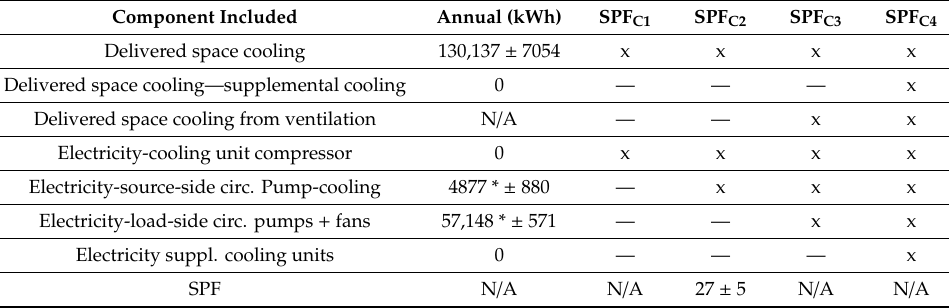
Table 4. Studenthuset cooling SPF with SEPEMO system boundaries.